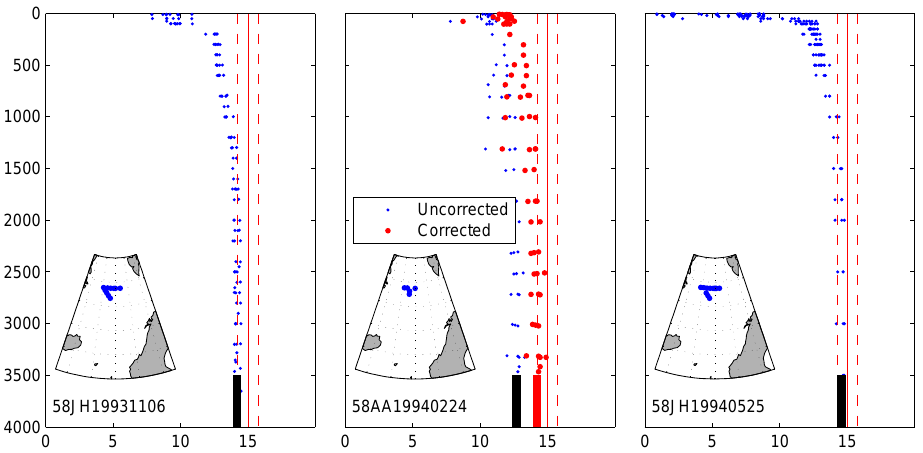
Figure 3. Greenland Sea (73–80 ◦ N, 10 ◦ W to 5 ◦ E) nitrate profiles from 58AA19940224 with (red) and without (blue) corrections applied, along with data from the previous and subsequent cruises. The thick vertical bars at bottom show mean values deeper than 1900 dbar. For reference, red solid and dashes lines have been drawn at 15 µ molkg − 1 ± 5%.